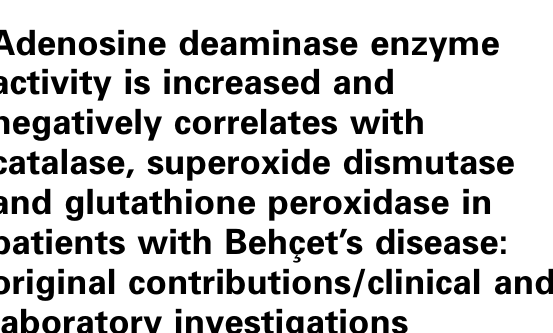
AIM : Behc¸et’s disease (BD) is an inflammatory vascu- litis with immunologic, endothelial and